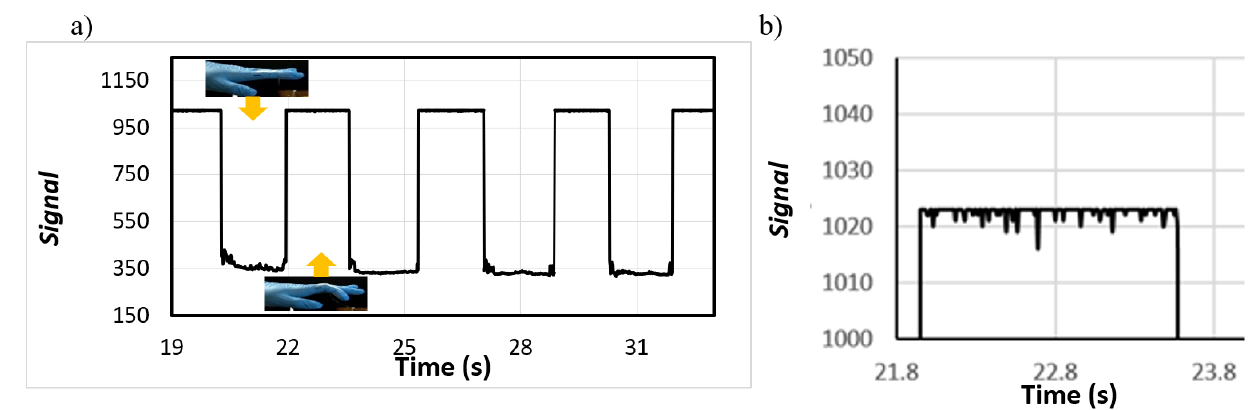
Figure 5. AgNW strain sensor response to finger bending movement for ( a ) five cycles and ( b ) a specific cycle.